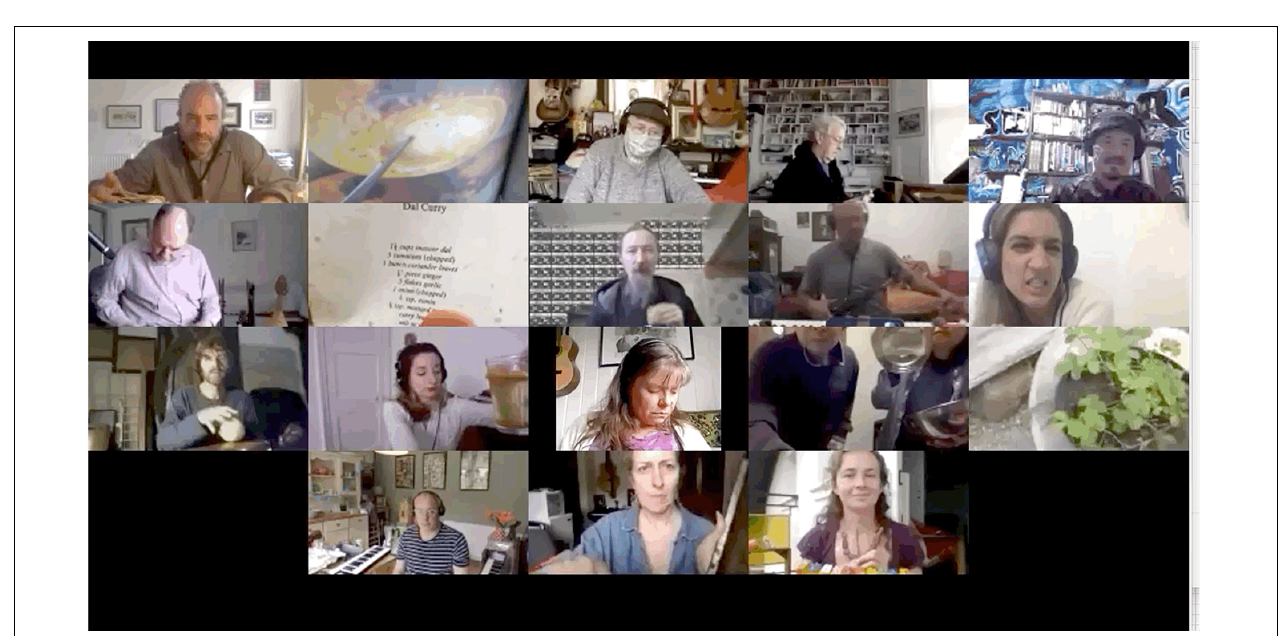
FIGURE 8 | Imitation and emergent bodily themes 2. The Gif version, highlighting musicians’ movement, can be found in the Supplementary Material .